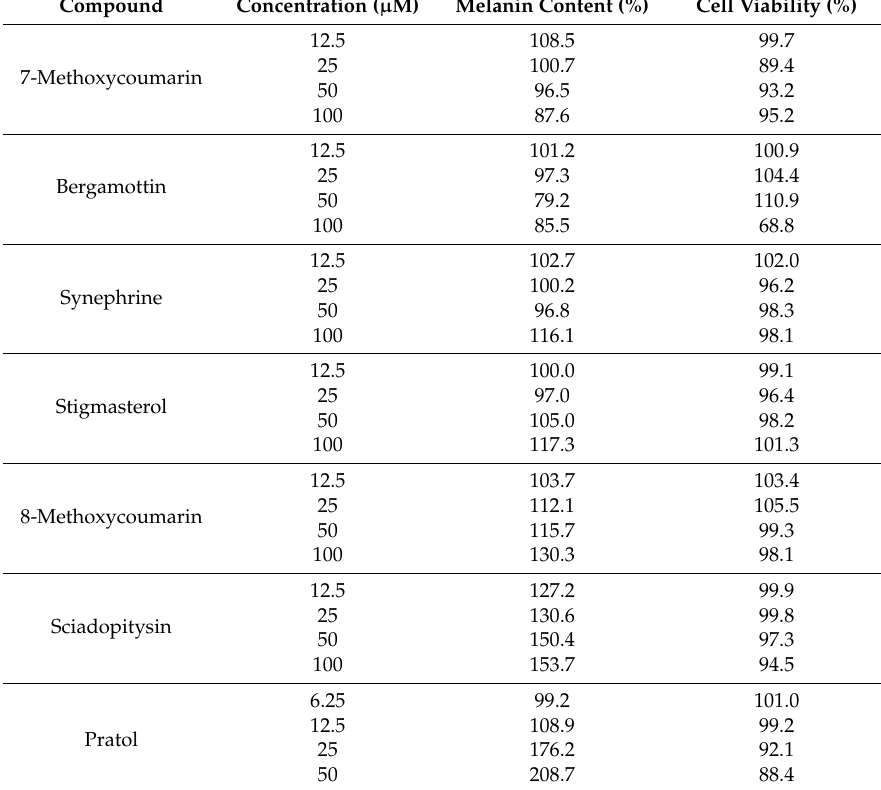
Table 1. Effects of some natural compounds on melanin production and the viability of B16F10 melanoma